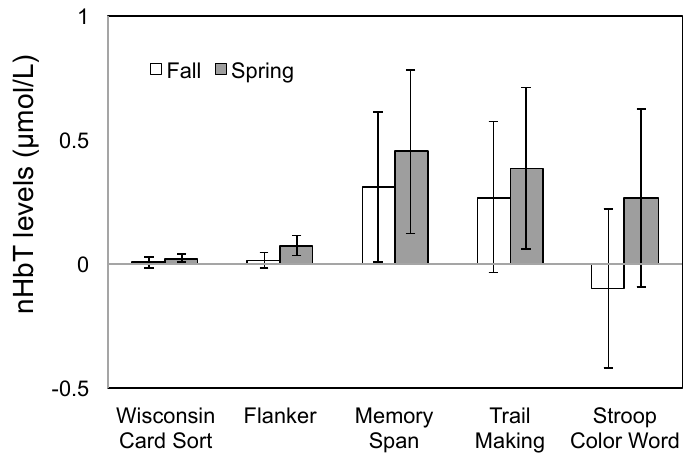
Figure 3. Total hemoglobin levels (nHbT) during the neurocognitive tests pooled across hemisphere. Error bars represent standard error.